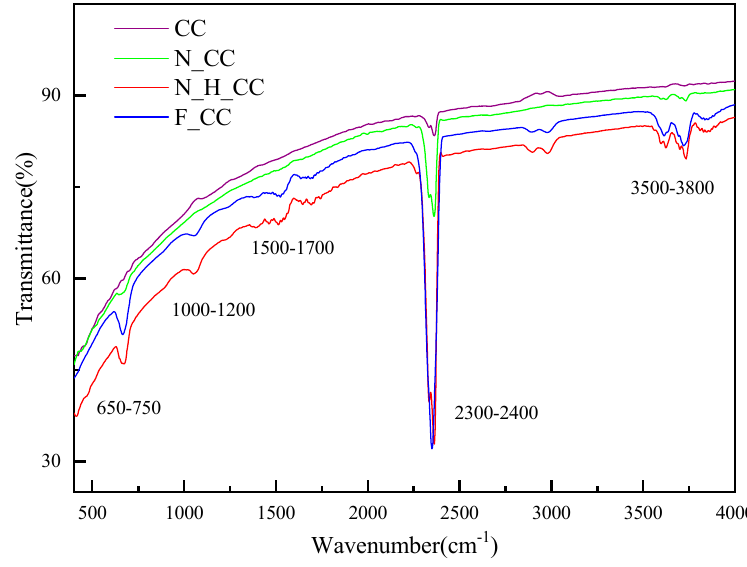
Figure 3. FT-IR spectra of the CC, N_CC, N_H_CC and F_CC.